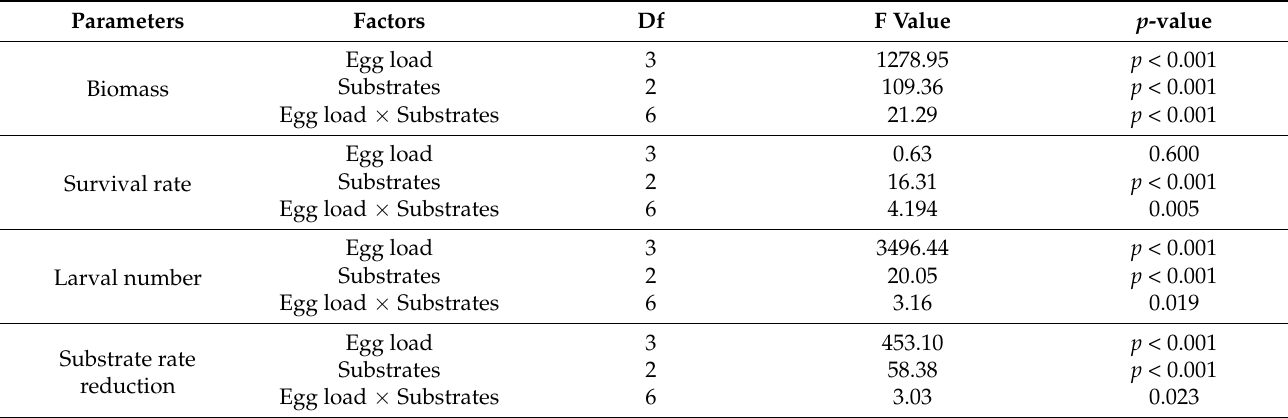
Table 1. Summary of the two-factor ANOVA test on the influence of egg load, substrate, and their interaction on the observed parameters.